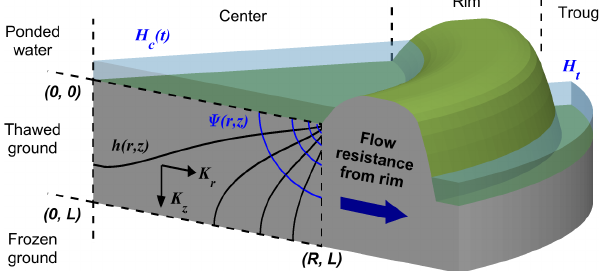
Figure 1. Pie wedge schematic diagram of 3D axisymmetric an- alytical model of inundated low-centered polygon drainage. The diagram represents an idealized pie wedge slice of a low-centered polygon including a wedge of the ponded center, rim, and trough. Equipotential hydraulic head lines are denoted as h(r,z) and stream- lines as (cid:57)(r,z) . L is the depth of the thawed soil layer, and R is the radius of the polygon center. The ponded water height ( H c (t) ) and trough water level ( H t ) are